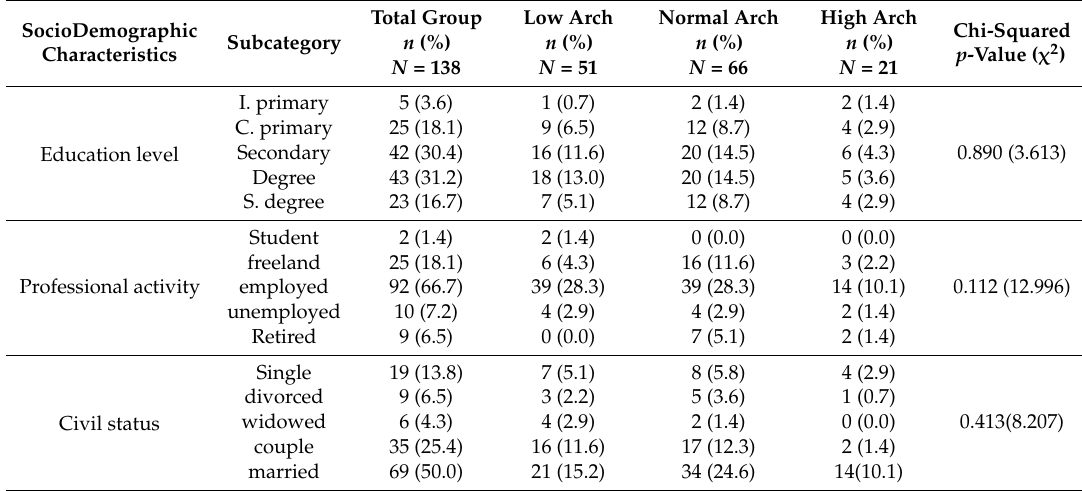
Table 2. Social characteristics of the sample population.